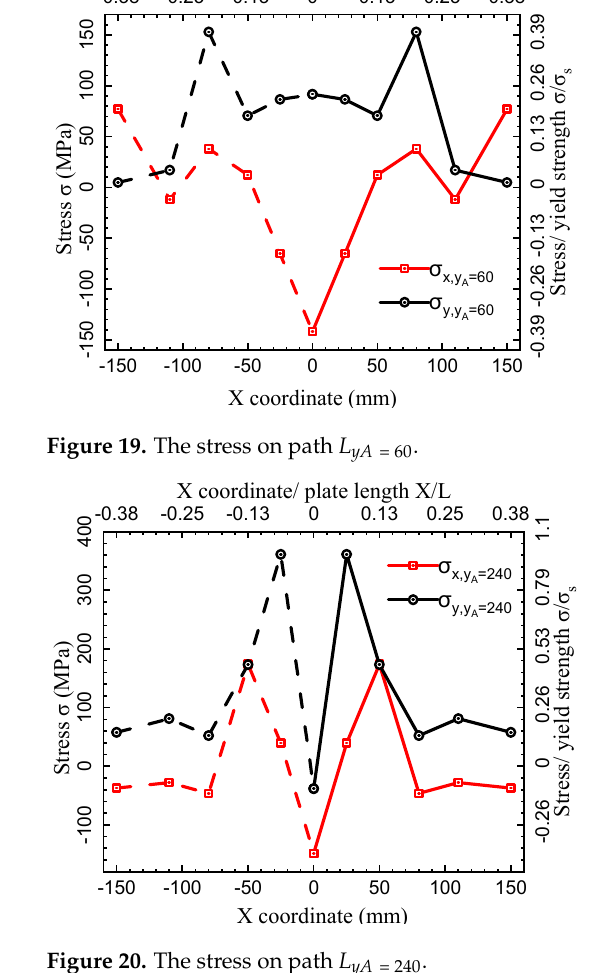
Figure 20. The stress on path 𝐿 (cid:3052)